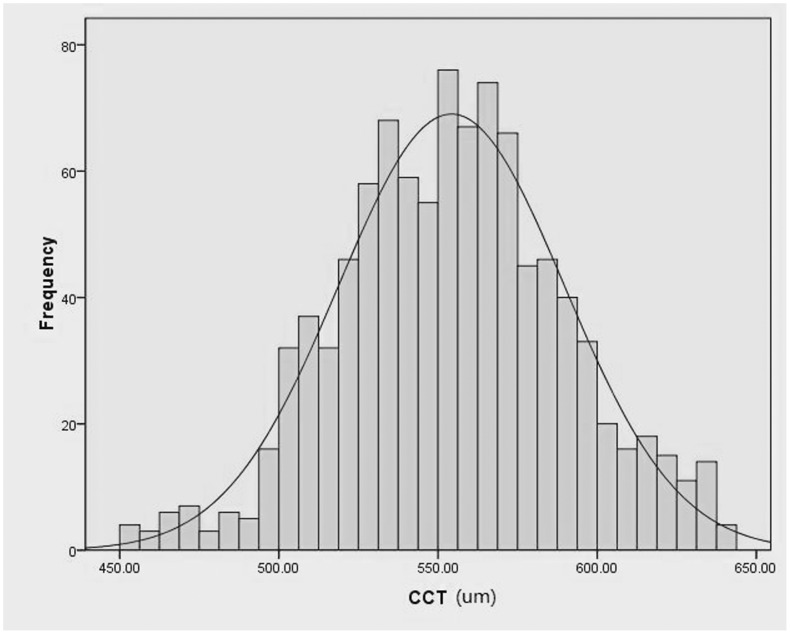
Distribution of central corneal thickness (CCT) in 982 eyes of children aged 7 to 18 years.CCT is normally distributed. The mean CCT was 554.19±35.46 µm.